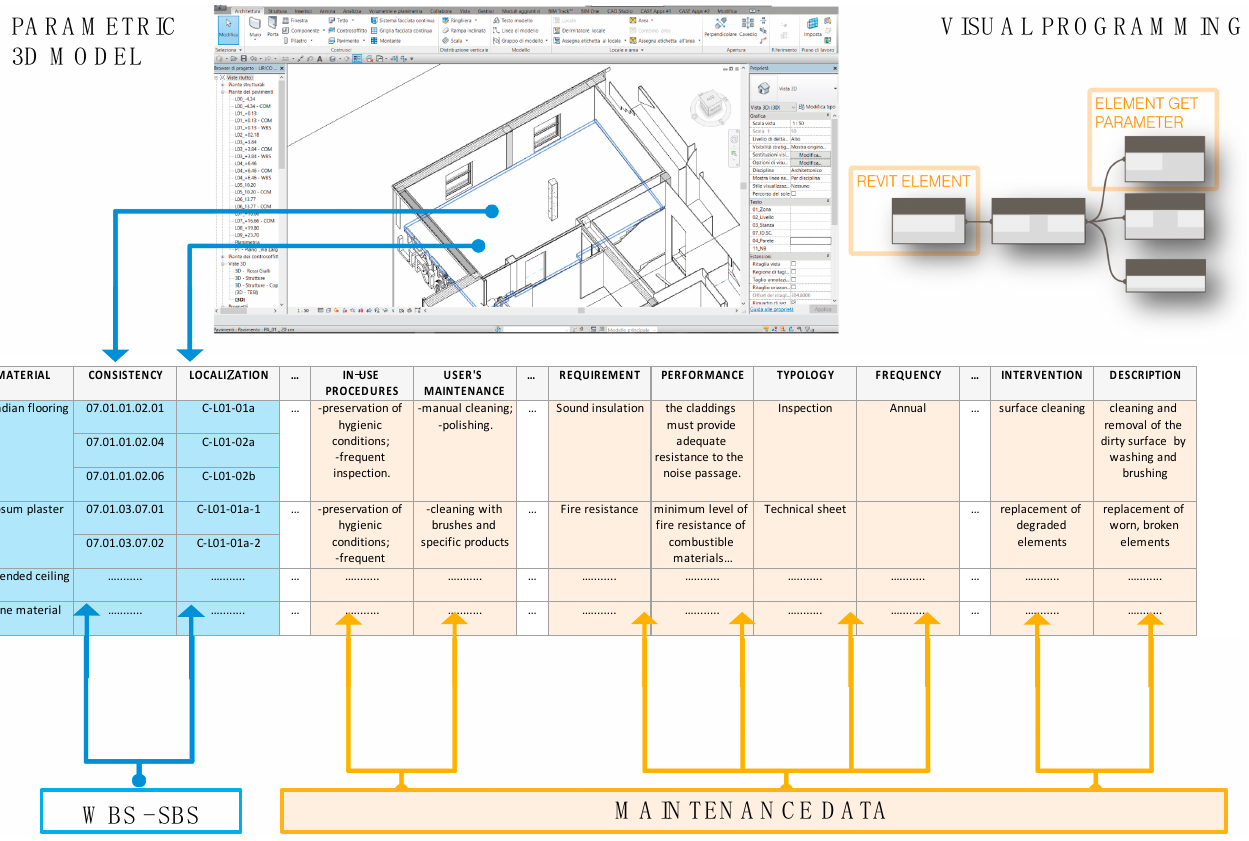
Figure 12. Integration of maintenance data.